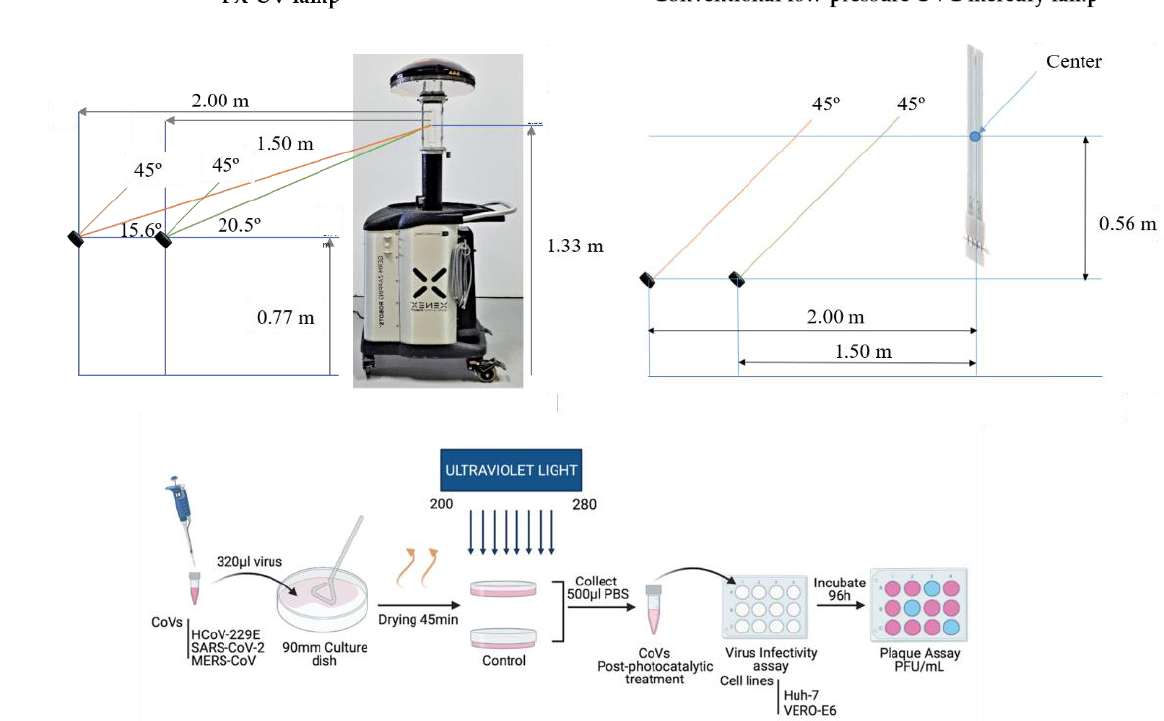
Figure 1. Schematic representation of the experimental conditions. ( A ) The UV light doses that samples received were measured by a detector anchored with an inclination of 45 ◦ and distances of 1.5 and 2 m with respect to the emission source. Distances were measured using a telemeter and the slope using a clinometer. ( B ) A 320 µ L drop of DMEM, containing 10 5 pfu of MERS-CoV, SARS-CoV-2, or HCoV-229E, was deposited on a 90 mm culture plate, spread, and dried for 45 min. After drying, viruses were irradiated with PX-UV for different time periods (0.5, 1, 2, 3, 4, and 5 min) at a 1.5 m or 2 m distance. Viruses were then collected in 500 µ L of PBS to determine the infectivity by a plaque assay in Huh-7 (HCoV-229E and MERS-CoV) or Vero E6 (SARS-CoV-2) cell lines. This illustration was created with Biorender.com.